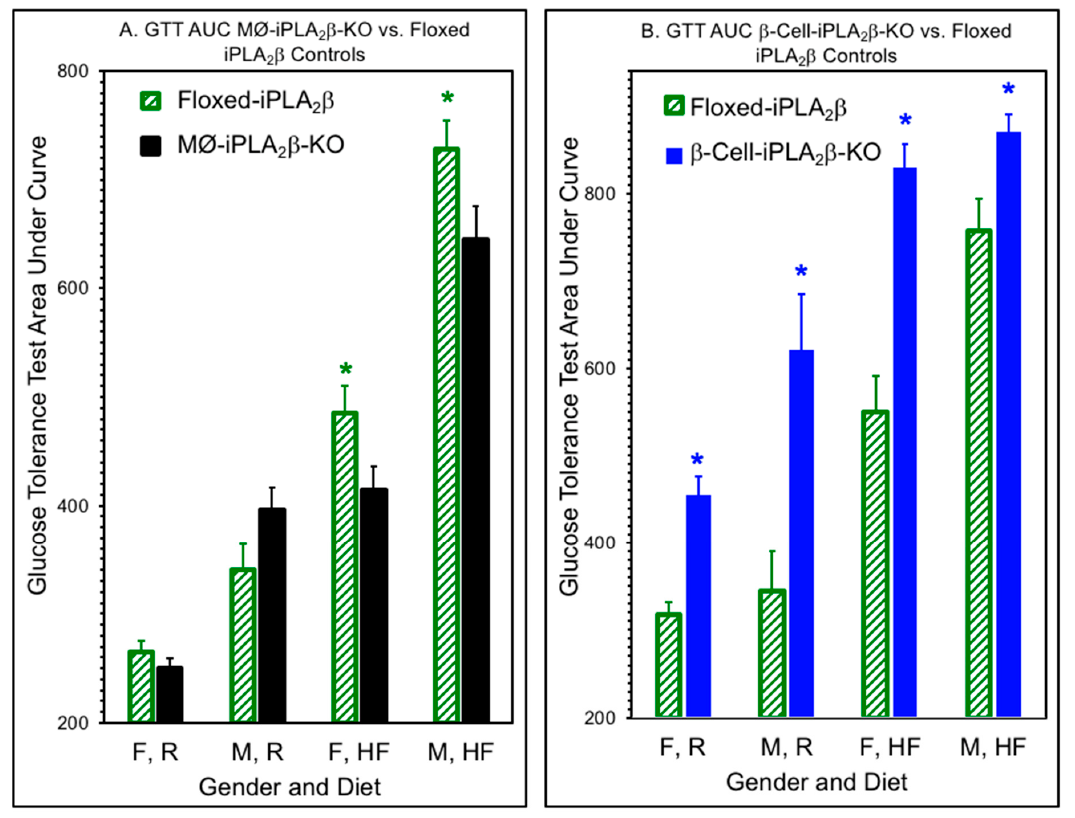
Figure 3. Areas under the curve for glucose tolerance tests for iPLA 2 β conditional knockout mice and floxed-iPLA 2 β controls. Glucose tolerance tests (GTTs) were performed as in Figure 2 for male (M) or female (F) MØ-iPLA 2 β -KO mice ( A ), β -cell-iPLA 2 β -KO mice ( B ), or floxed-iPLA 2 β control mice 6